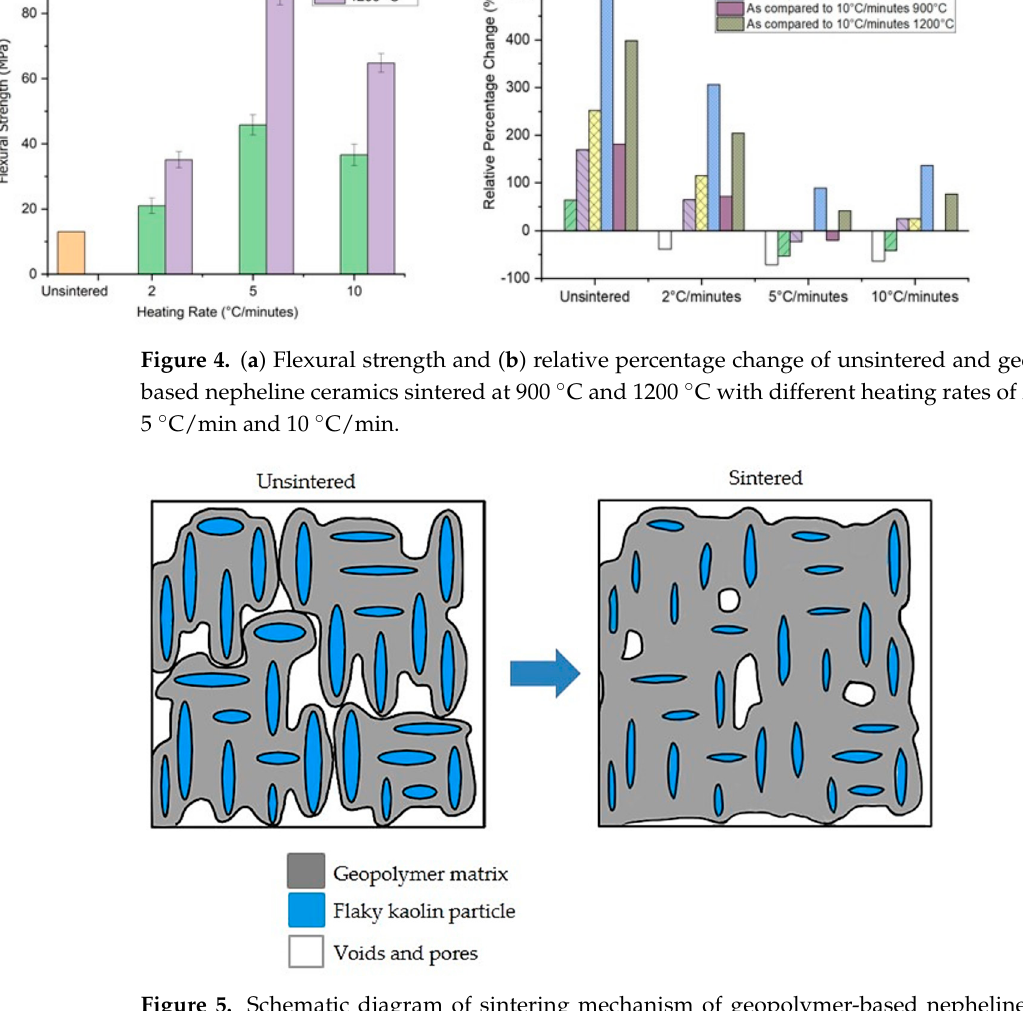
Figure 5. Schematic diagram of sintering mechanism of geopolymer-based nepheline ceramics sin- tered at 900 °C and 1200 °C.